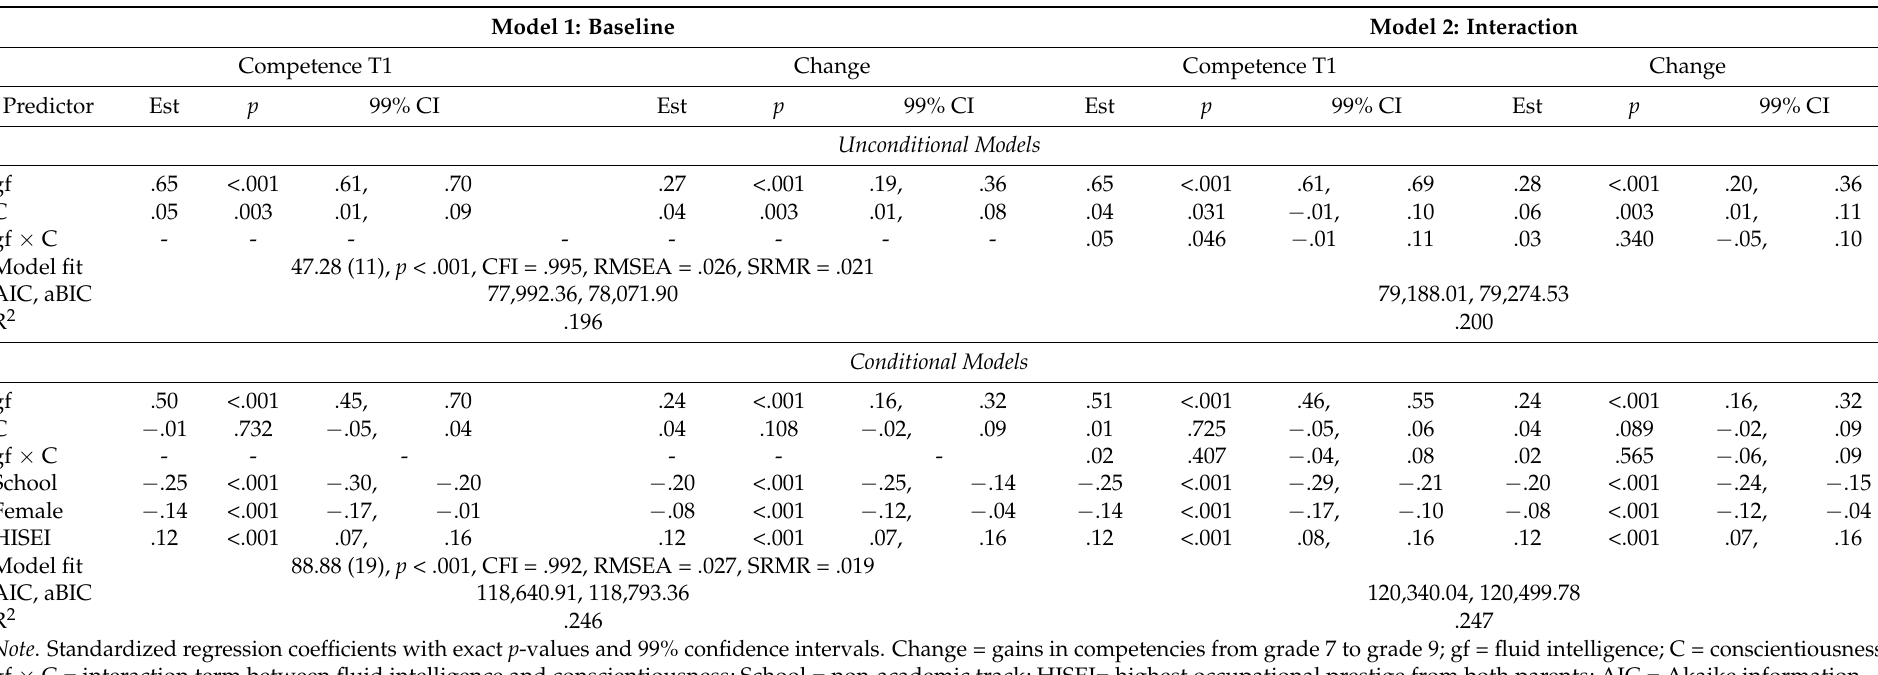
Table 7. Latent change score models predicting mathematic competence baseline levels and gains in